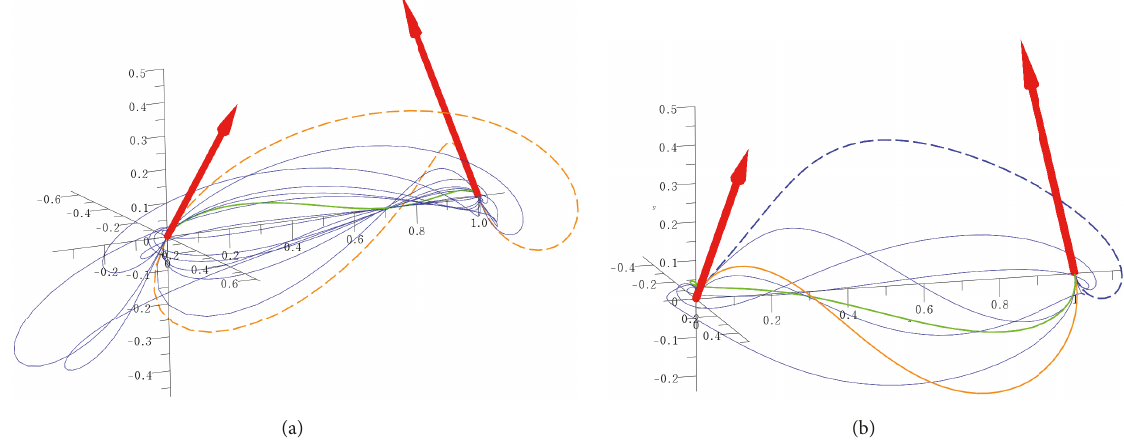
Figure 5: Comparison of interpolants satisfying 𝐻 1 𝐶 = { p 0 = (0,0, 0), p 1 = (1,0, 0), k 0 = (0, 1,1), k 1 = (0, 1, −1)} of Example 11 in [24]: (a) 16 interpolants obtained by using general PH-preserving cubic mappings; (b) 8 interpolants obtained using the s-Enneper surface. In each subfigure, the interpolant with the lowest bending energy is shown as the orange curve; the shortest interpolant is shown as the green curve; and the longest interpolant is shown as the curve denoted by dashed lines.